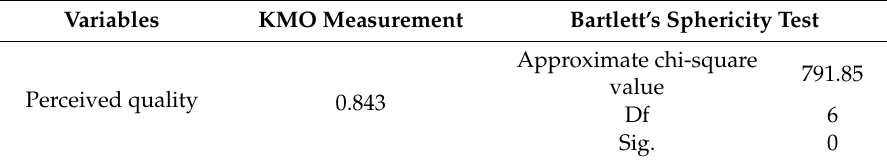
Table 6. KMO and Bartlett’s sphericity test.